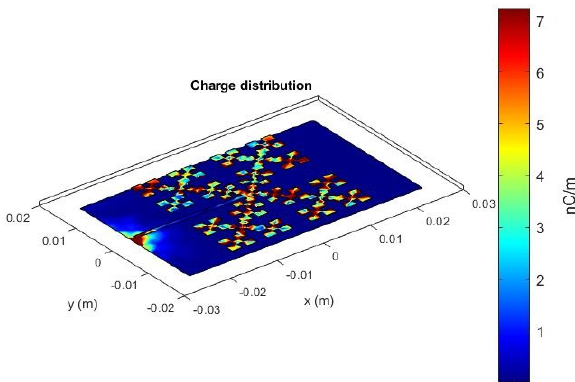
Figure 4. Charge distribution of fractal island antenna.